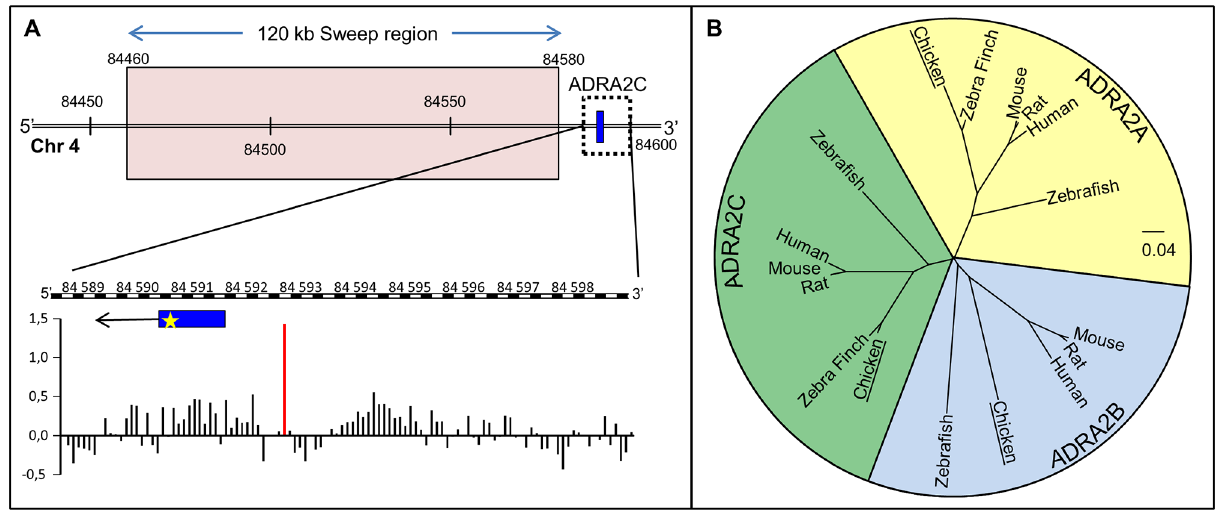
Figure 1. Positional information on the location of ADRA2C in relation to a neighboring selective sweep and methylated regions from previous studies. A) Location of the ADRA2C in chromosome 4 in relation to the selective sweep region reported by Rubin et al. (2010). All coordinates are expressed as kb. The position of the 1229 bp long gene starting at 84590769 is represented by a blue box and the SNP in position 84590997 used for genotyping is shown as a yellow star within the gene. The direction of transcription is indicated with an arrow. The methylation pattern (in Log2 fold change) comparing RJF and WL, shown with a resolution of 50–75 bp regions is shown in the bar graph, and the hypermethylated region is highlighted with a red bar at position 84593087. Methylation data from Na¨tt et al. [16]. B) Peptide sequence homology phylogeny of the annotated sequences of a 2 adrenergic receptor subtypes cluster the chicken ADRA2C gene to better characterized mammalian ADRA2C genes.